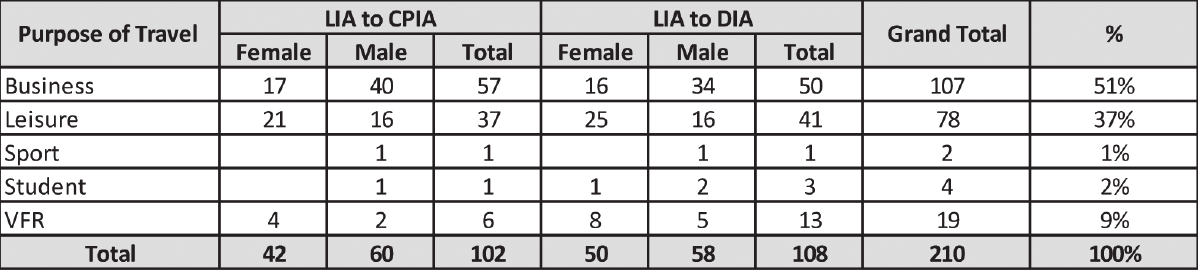
Table 3: Purpose of travel